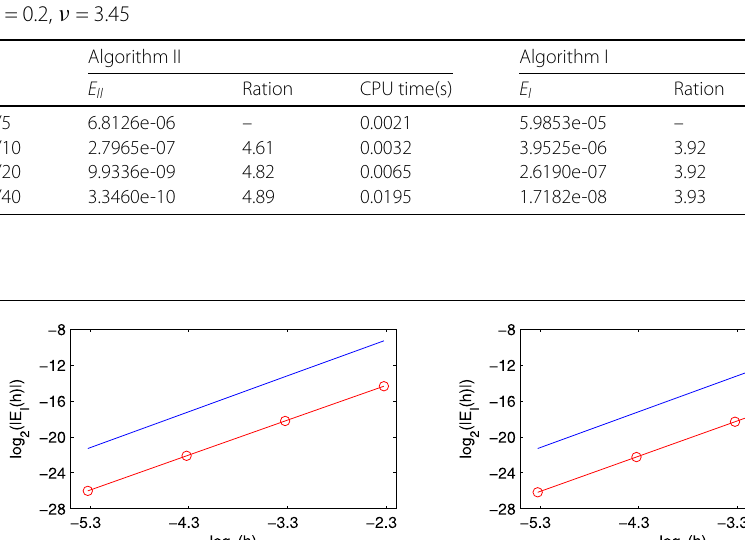
we plot the EOC for different values of α at the time t = 1. Figure 9 examines the EOC